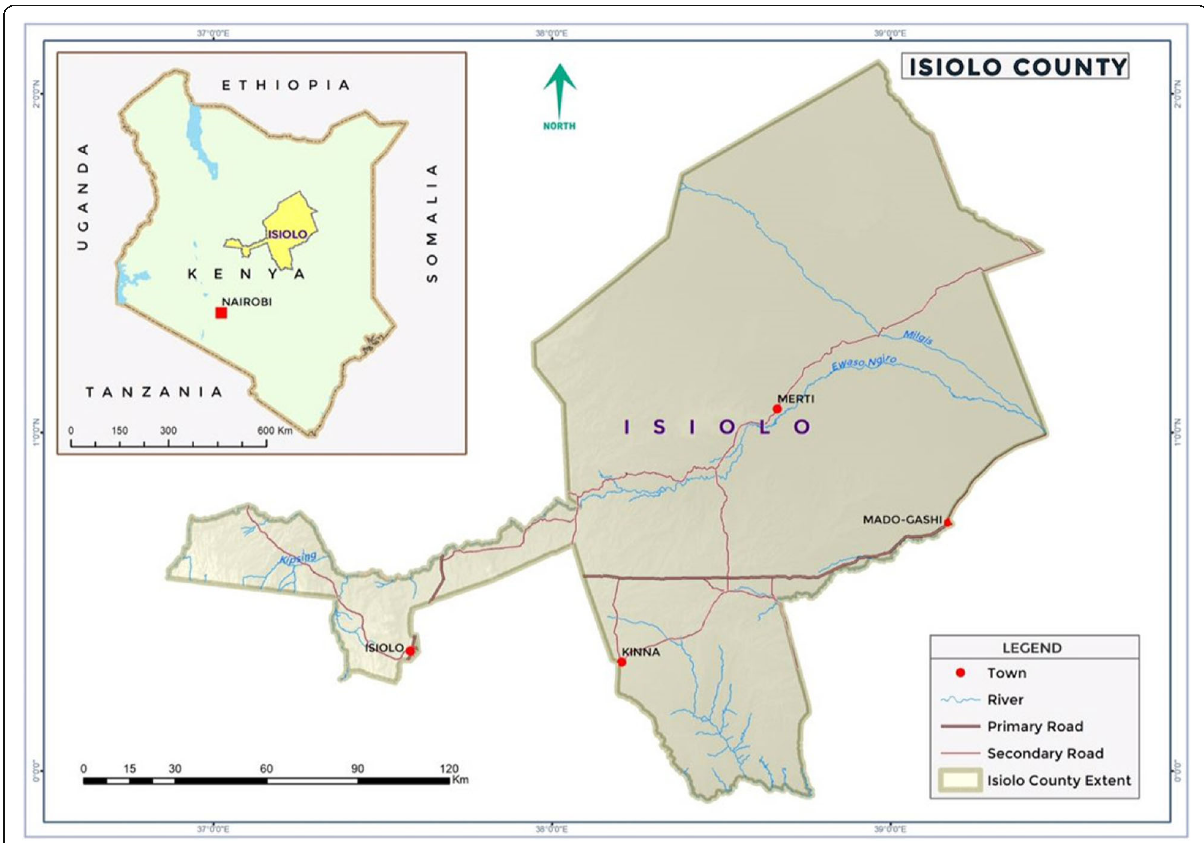
Figure 1 Map of Kenya showing Isiolo County and Nairobi